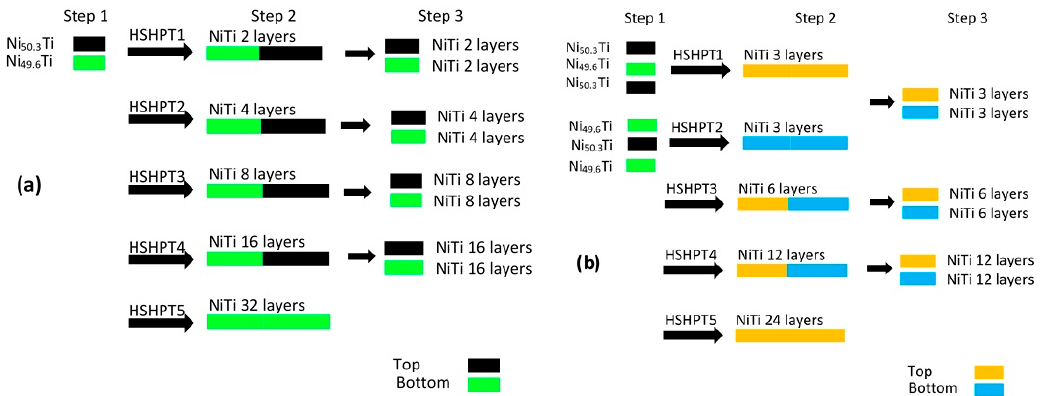
Figure 1. Processing route of Ni 50.3 Ti/Ni 49.6 Ti composite discs cut in half and assembled as